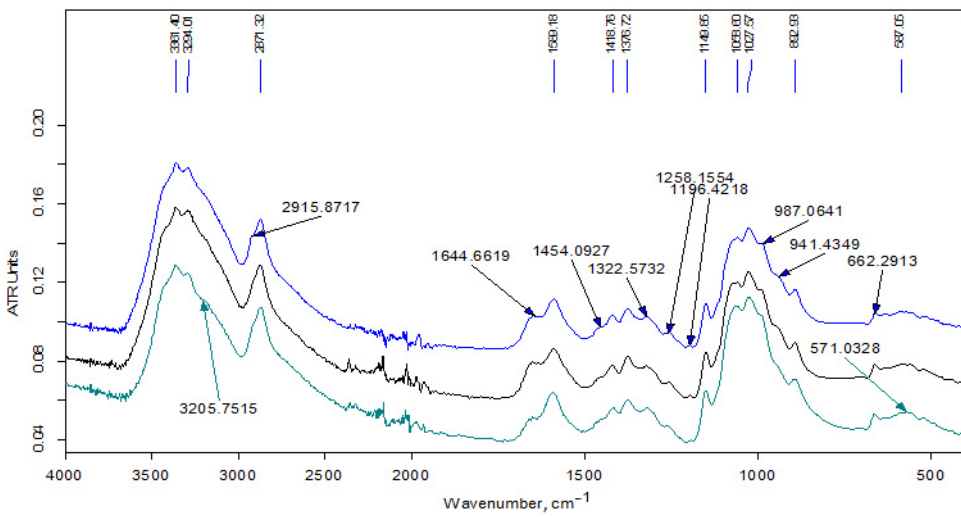
Figure 3. FT-IR spectra of the samples (bottom to top): chitosan Ch2-LMw; chitosan Ch1-LMw; fraction Ch1-L- С16 -3s.